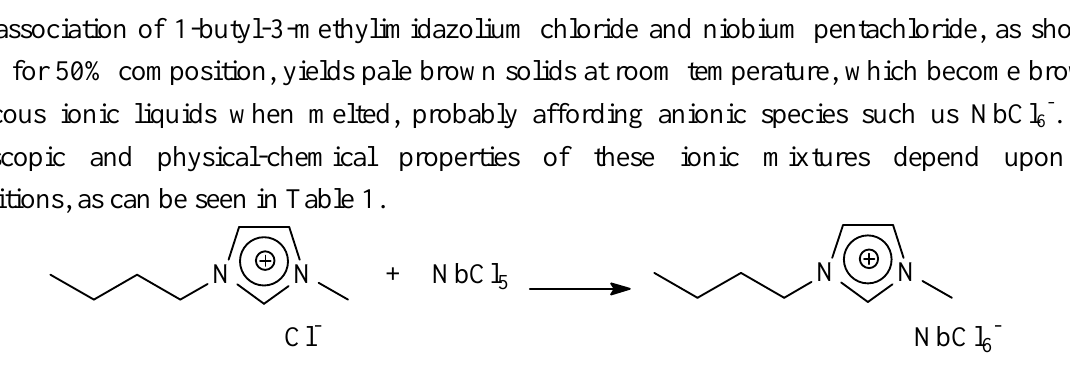
Figure 1. Association of 1-butyl-3-methylimidazolium chloride and niobium